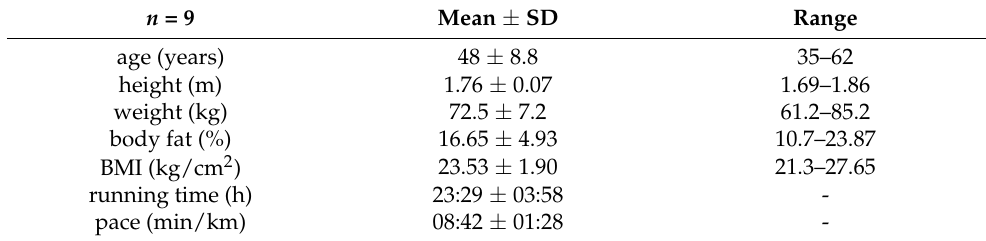
Table 1. Characteristics of the